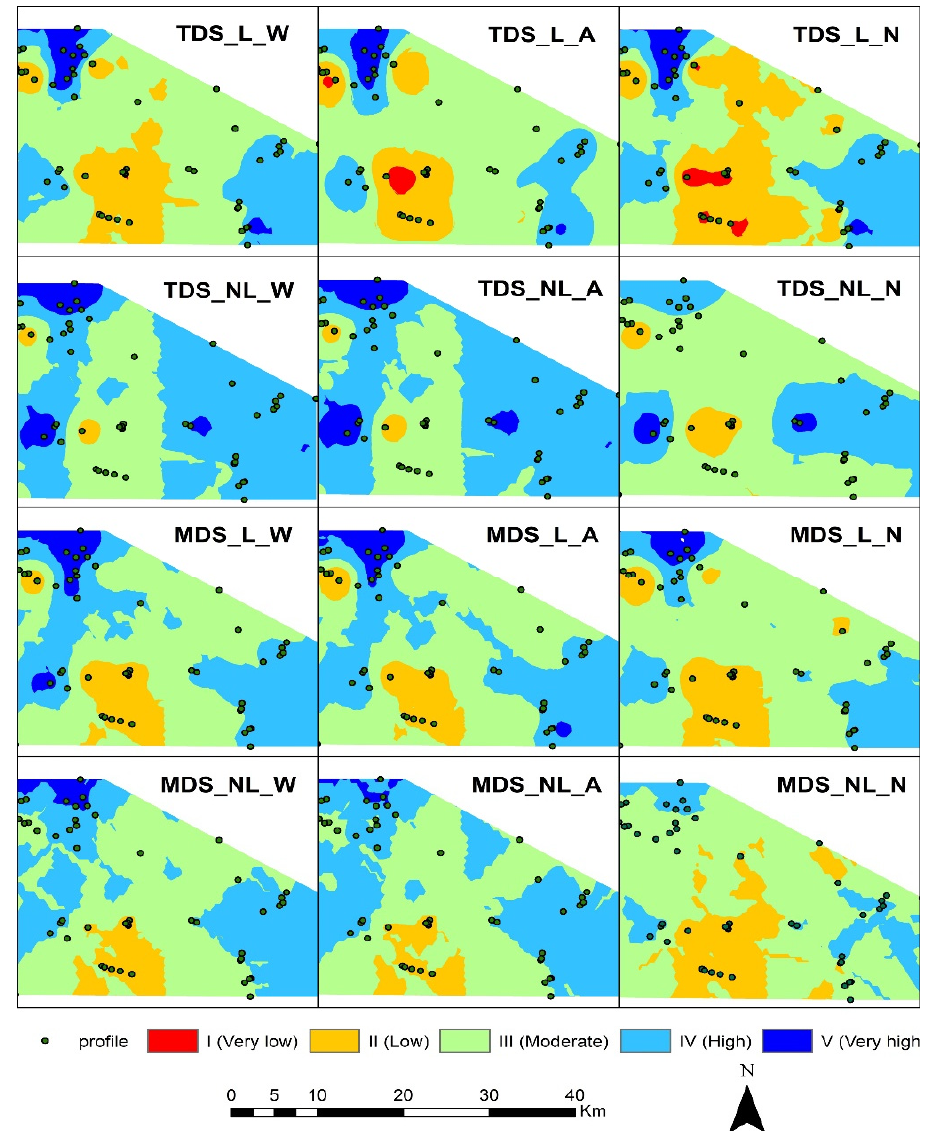
Figure 5. Spatial distribution of soil quality grades for twelve SQIs calculated using the Total Data Set (TDS) and Minimum Data Set (MDS), Linear Score (L), and Nonlinear Score (NL) equations) and weighted additive method (W), additive (A) and Nemoro (N), in the soils of the Campo de Montiel-Sierra de Alcaraz sector.